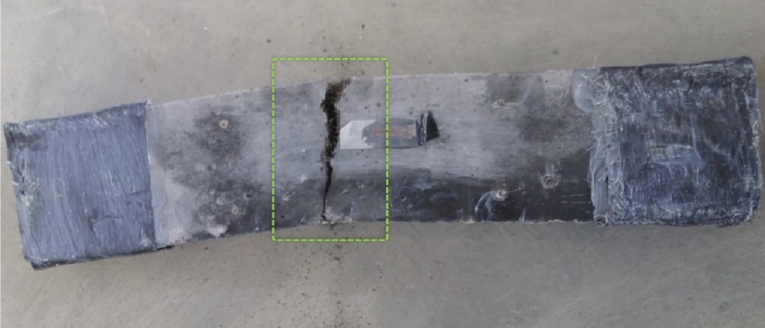
Figure 14. Failure of beam (direct tension test) from mixture 2(0–2)/16/6.1. In Figure 15, full stress–displacement curves from indirect tension (three-point bend- ing) tests are shown. The modulus of elasticity from the flexural tensile test was, on average from two identical beams, 24, 30, 37, and 31 GPa for mixtures 0/16/6.1, 2(0-2)/16/6.1, 6(5-1)/16/6.1, and 6(3-3)/16/6.1, respectively.